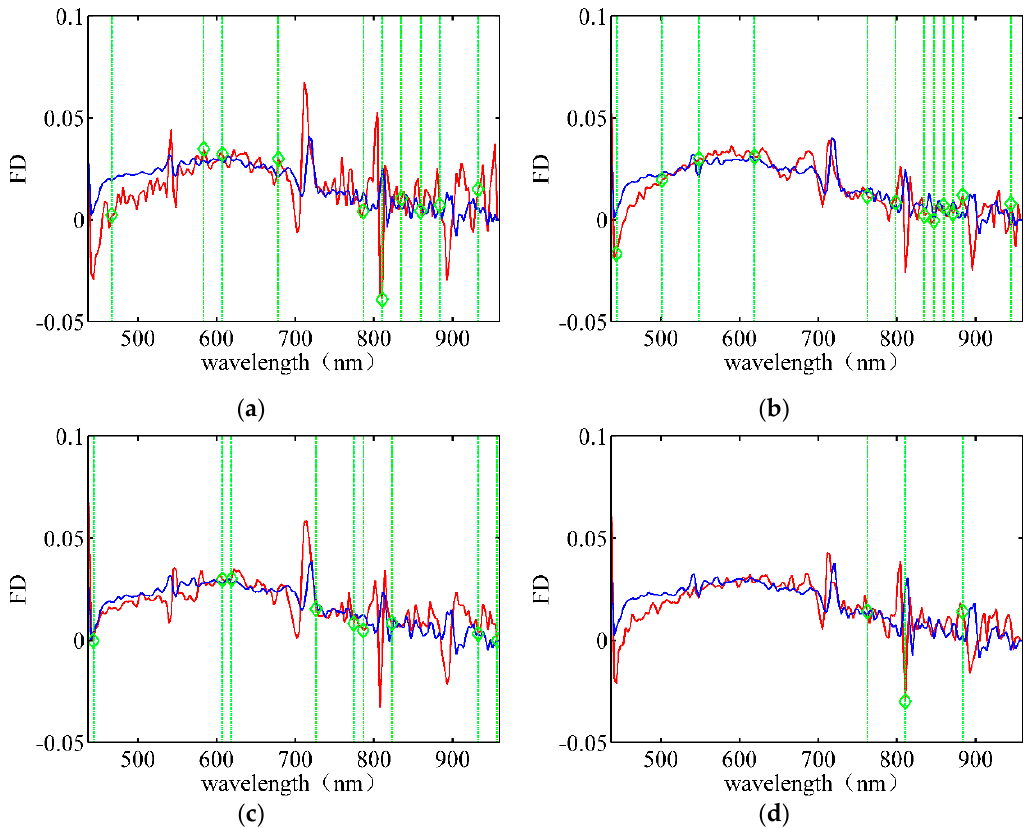
Figure 8. Wavelength band selection using FD data for different rice varieties under the optimal λ . ( a ) Huguangxiang. ( b ) Xiangwan Japonica. ( c ) Huanghuazhan. ( d ) Japonica 530.